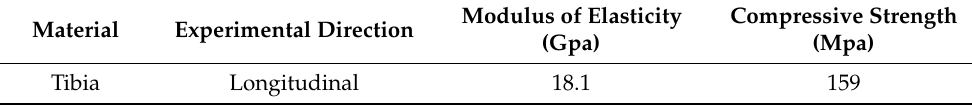
Table 1. Mechanical properties of